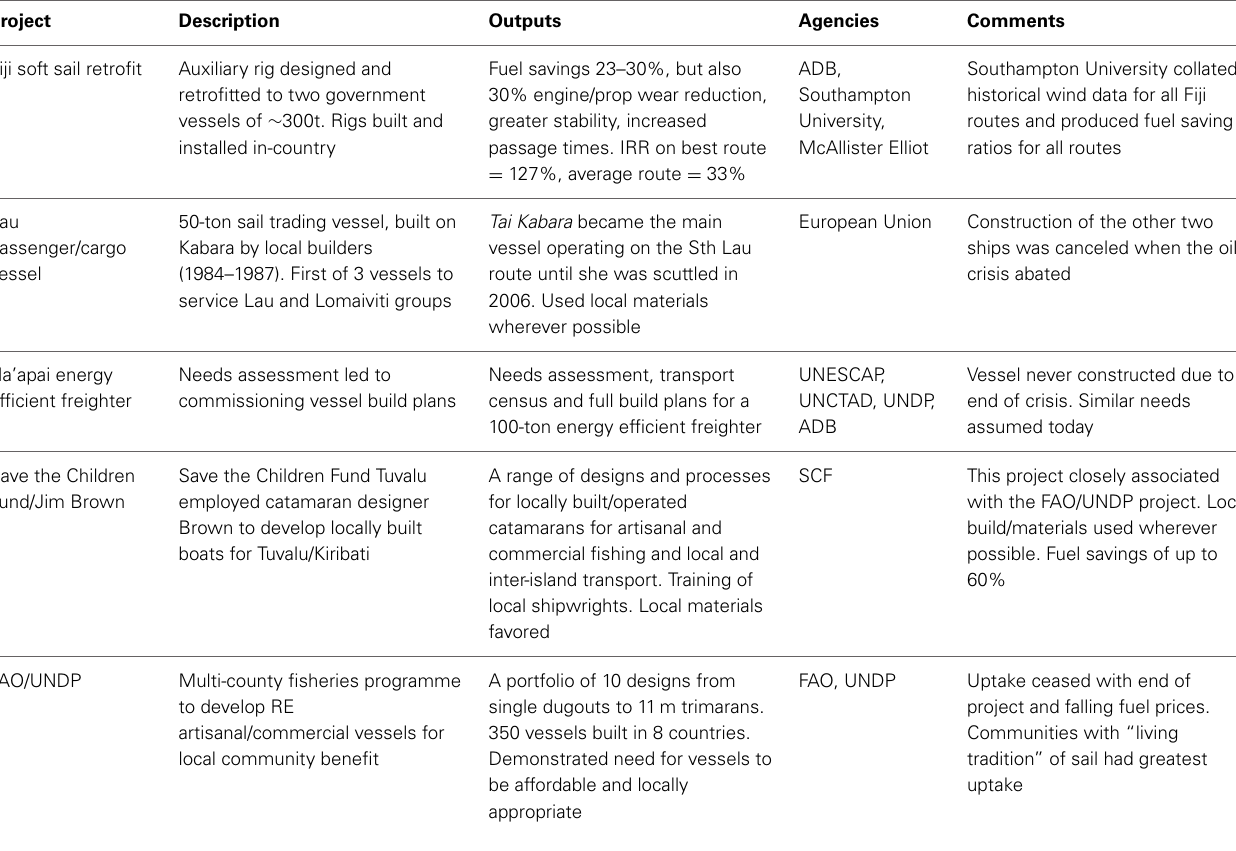
Table 1 | Pacific Island based programs for renewable energy shipping during the 1980s oil crisis (sources: Brown, 1982; ADB, 1985; Satchwell, 1985, 1986; FAO, 1987; Nuttall,